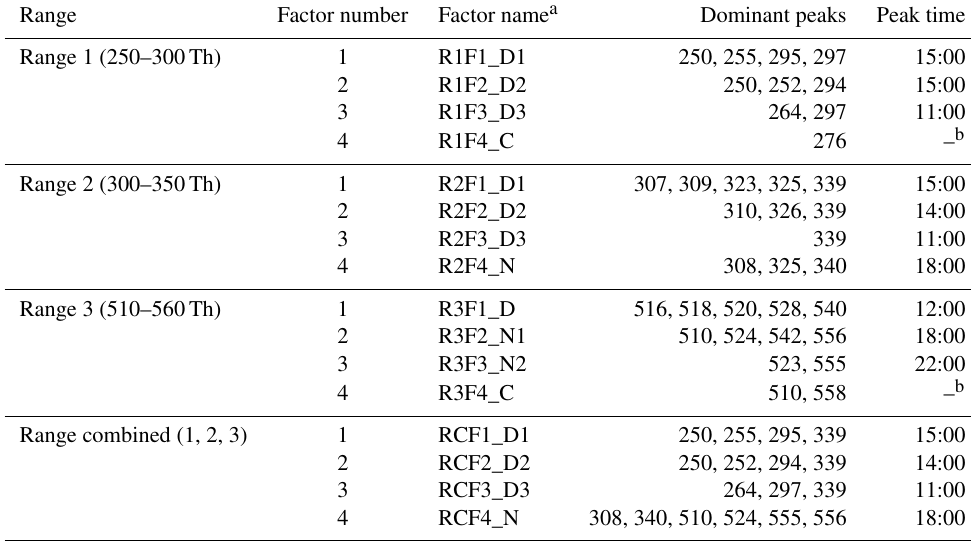
Table 1. Summary of PMF results for the different mass ranges. Range Factor number Factor name a Dominant peaks Peak time